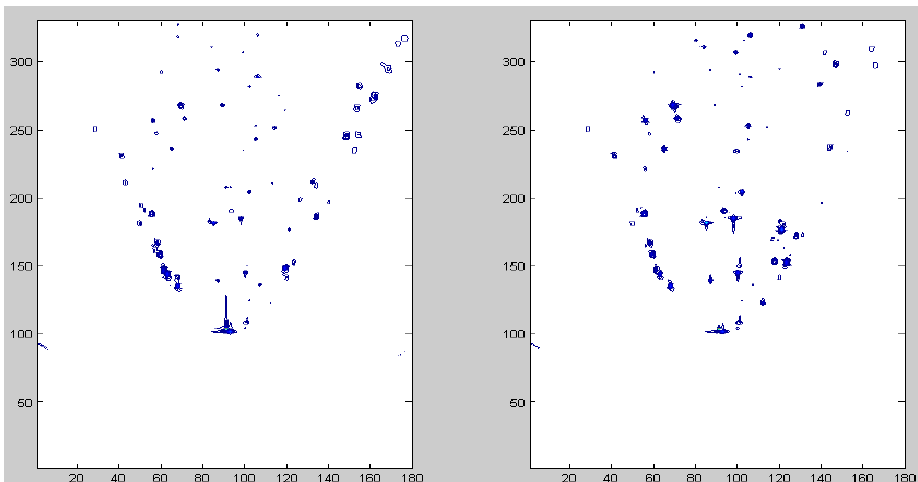
Fig. 11. Comparative radar images for two-channel radar with pulse radiation.